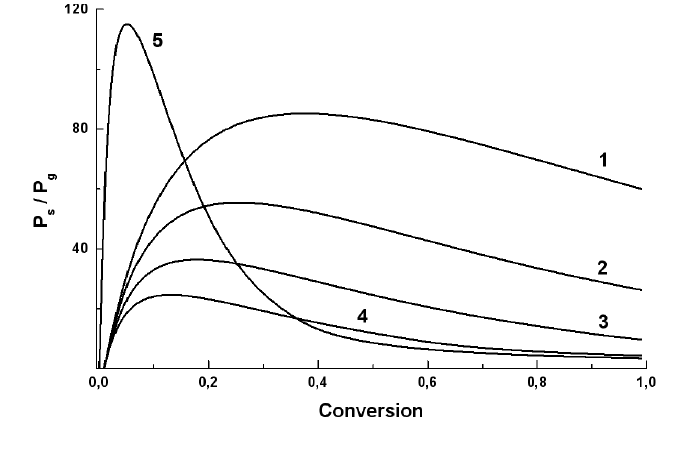
Fig. 4 Dependencies of the › value on the monomer conversion, the role of the initial monomer and initiator concentrations (benzene, ¬ = 0.95, " = 1). [M] 0 /[I] 0 = 100 (1-4), 1000 (5); [M] 0 = 0.5 (1), 1.0 (2), 2.0 (3), 4.0 (4-5)